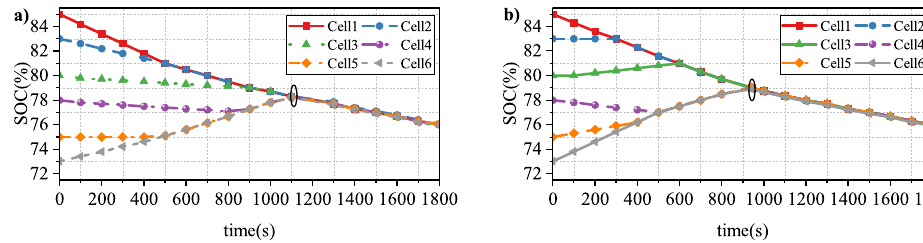
Figure 16. The equalization process of FPID and VFPID in charging state: ( a ) FPID; ( b ) VFPID.